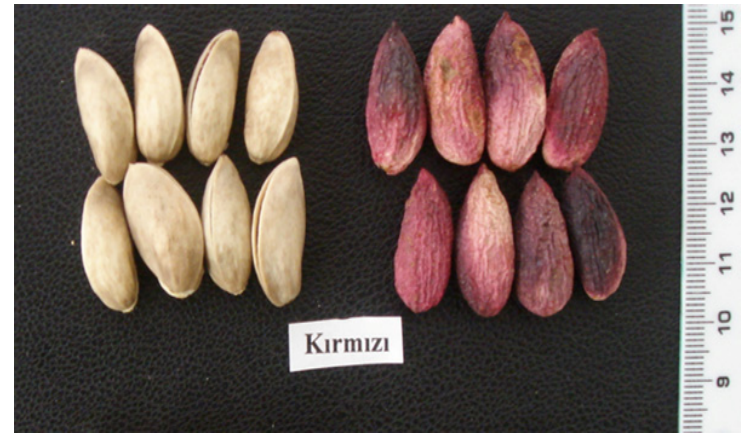
Figure 1. Nuts of P. vera L. cv. Kirimizi. (Own photography). Samples of leaves, fruits (Figure 2) and shoots from 30-year-old ‘Kirmizi’ pistachio trees from Nizip region of Gaziantep, in 4 different periods from the beginning of May to the end of July from the thinning applied and non-applied branches, were used. Applied trees were thinned 1 month before first sampling date. Leaf, fruit (Figure 2) and shoot samples of this variety were brought from Gaziantep to Adana province in the cold chain condition and after harvesting immediately treated with liquid nitrogen and dried by freeze drying with a coffee grinder and stored at − 80 ◦ C until analyzed. The analyses were carried out in